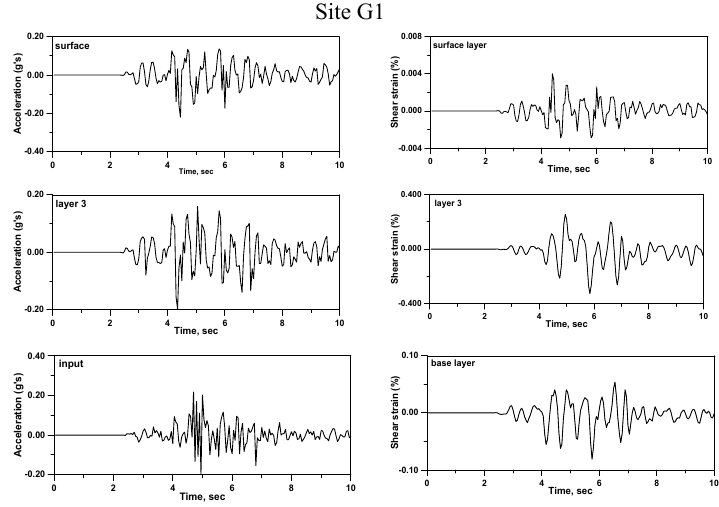
Fig. 23. Acceleration (left column) and strain (right column) time histories at different ground level.